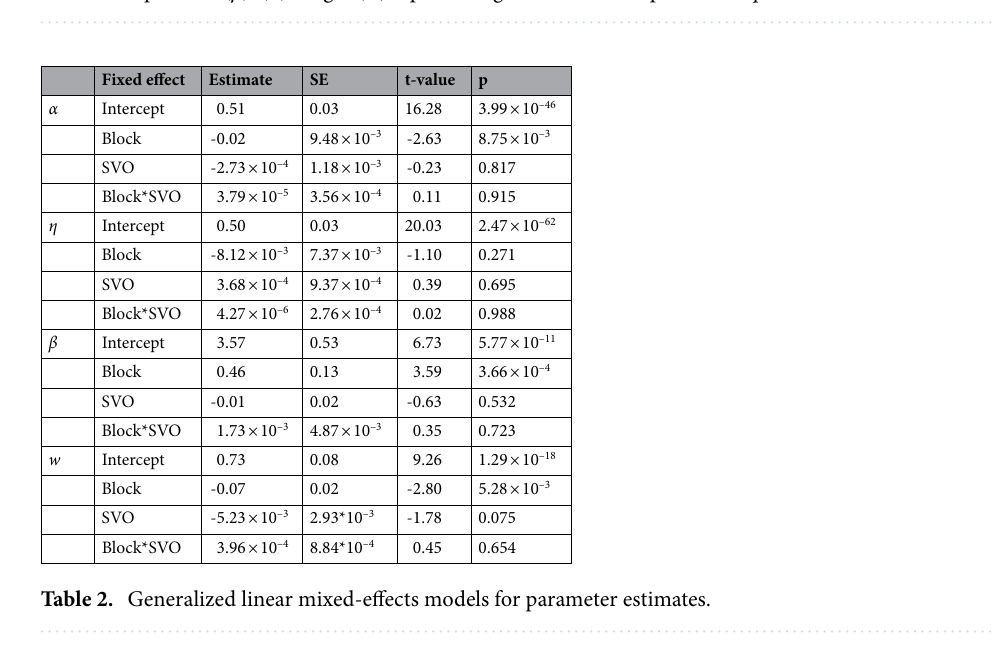
Figure 5. Comparing estimated parameters between the proself and prosocial groups. ( a ) Model-free learning rate ( α ) estimated by the model analysis, divided into the proself and prosocial groups. Blue indicates the proself group; magenta indicates the prosocial group. Error bar indicates SEM. ( b ) Model-based learning rate ( η ). ( c ) Inverse temperature ( β ), ( d ) weight ( w ) representing model-based dependence. * p < 0.05.